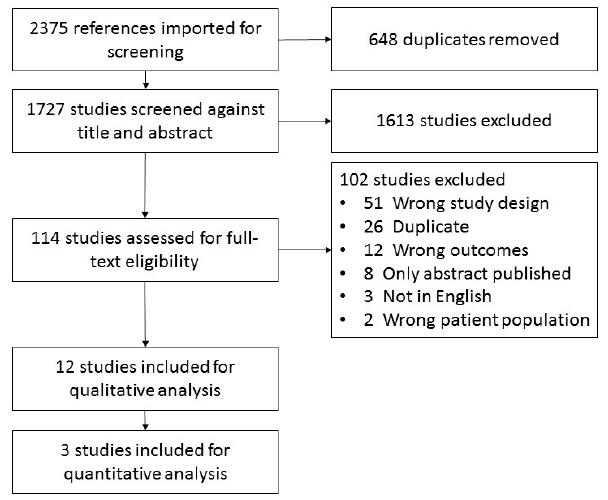
Figure 1. Systematic review flow diagram.